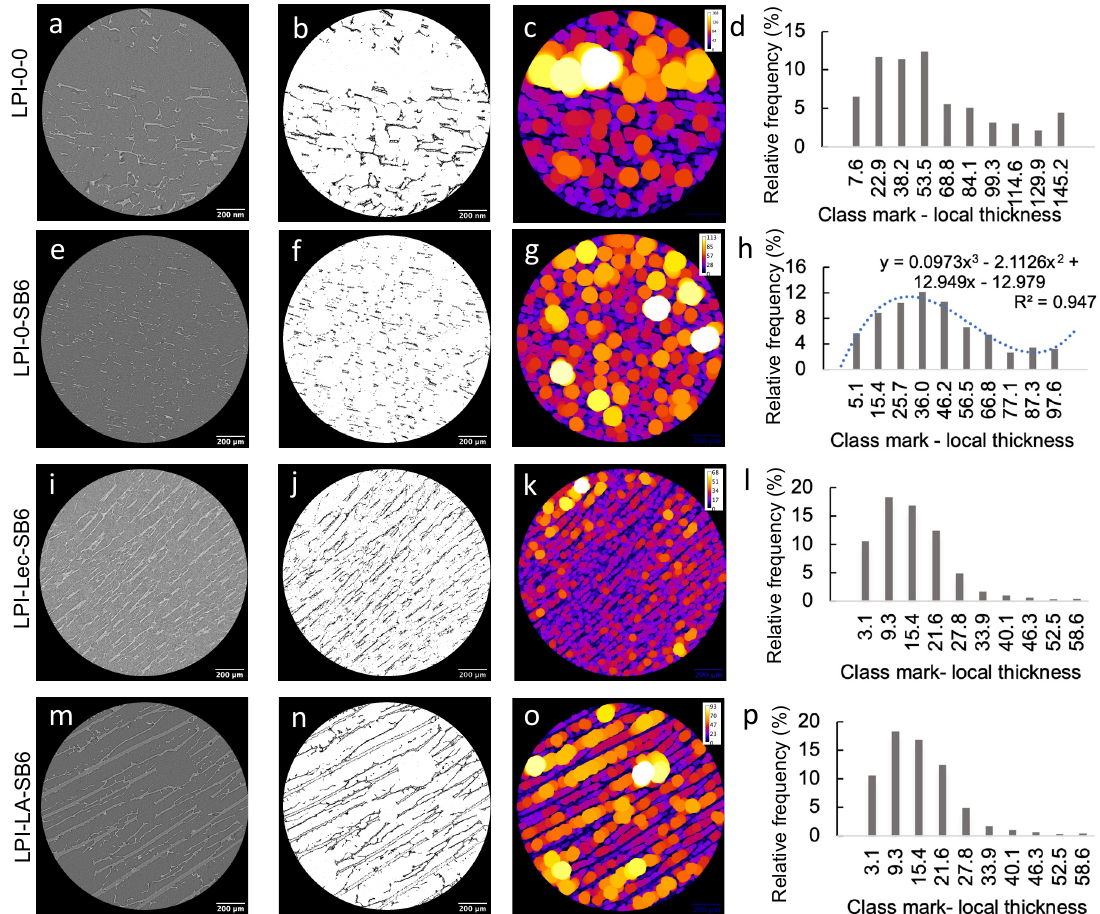
Figure 6. The images on the horizontal refers to the x-ray tomograph, tomograph image after threshold treatment, local thickness analysis and local thickness histogram. ( a – d ): LPI-0-0; ( e – h ): LPI-0-SB6; ( i – l ): LPI-Lec-SB6; ( m – p ): LPI-LA-SB6.